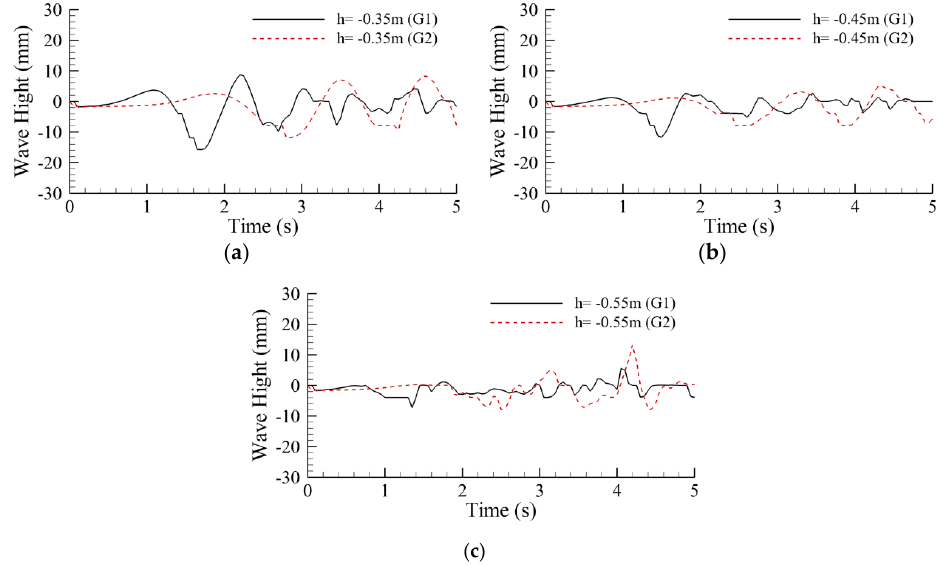
Figure 8. The temporal evolution of the water elevation in G 1 and G 2 with submarine landslide: ( a ) h = 0.25 m; ( b ) h = 0.15 m; and ( c ) h = 0.05 = 0.25 m; ( b ) h = 0.15 m; and ( c ) h = 0.05 m. ( a ) h